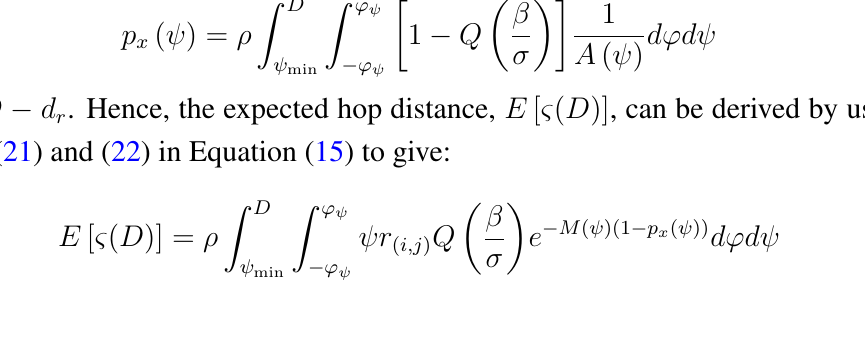
Figure 10. Expected hop distance vs . the number of CRSN nodes in the